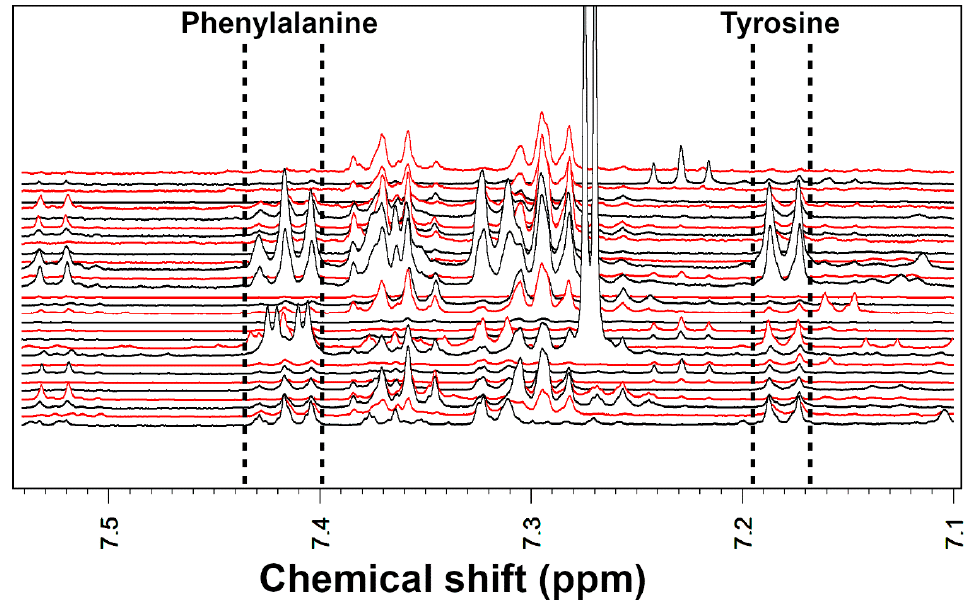
Figure 5. Portions of the NMR spectra employed for the quantification of phenylalanine and tyrosine. Samples collected at T0 and T6 are represented with black and red colours, respectively.